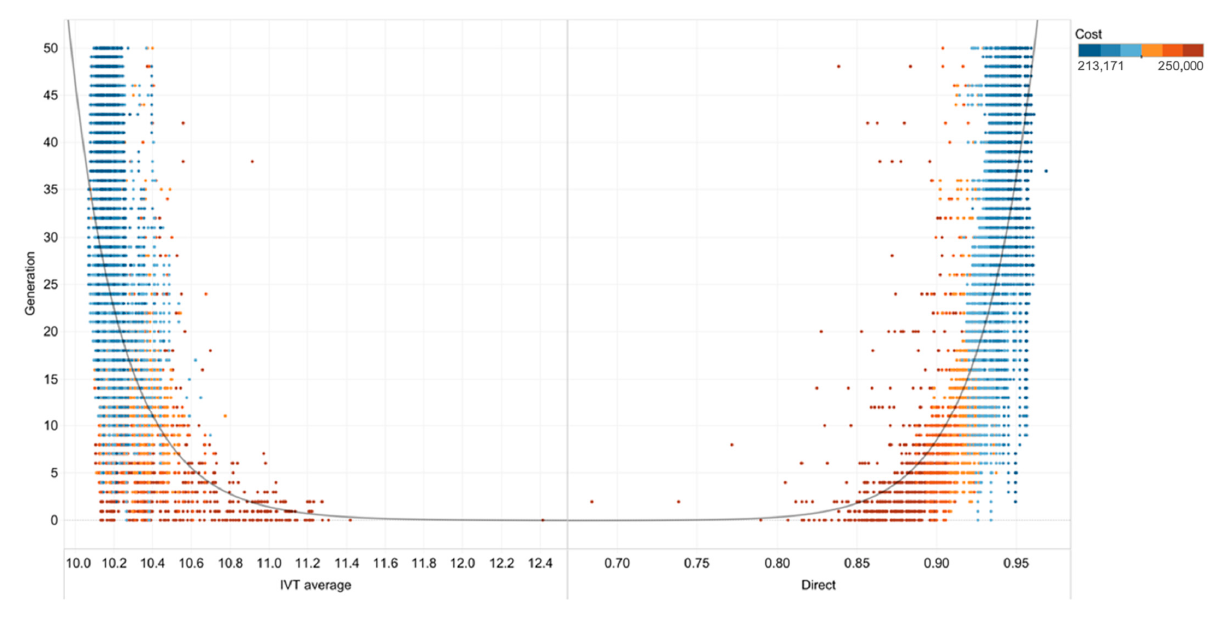
Figure 8. Average load per vehicle per generation (color signifies direct route percentage).